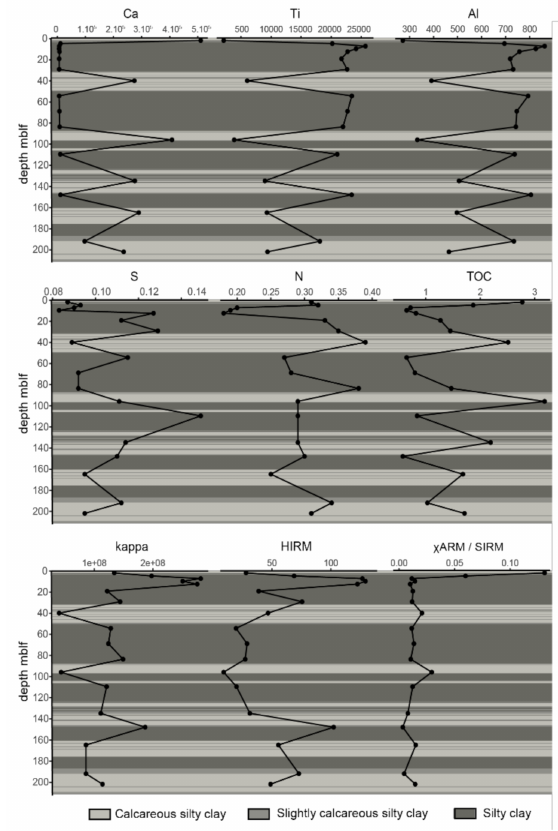
Figure 2. Profiles of elemental composition and ratio along the core, with corresponding sedimentary facies as described by Francke et al.